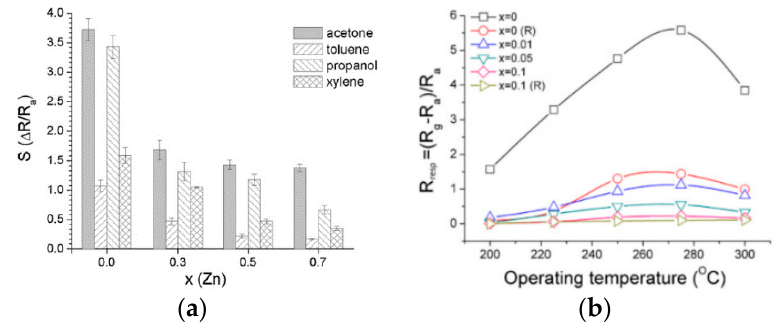
Figure 22. ( a ) Response of Ni 1 − x Zn x Fe 2 O 4 compositions for various aimed gases [99] ( b ) Response of Ni 1 − x Co x Fe 2 O 4 compositions for 500 ppm acetone in various operating temperature [100].